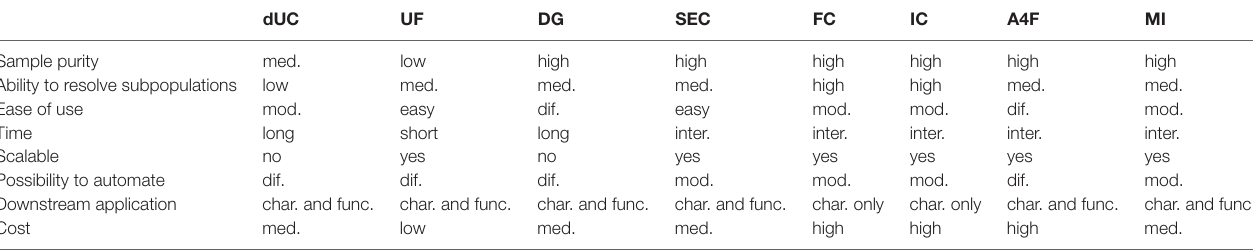
TAbLe 1 | Advantages and disadvantages of isolation techniques. dUC UF DG SeC Sample